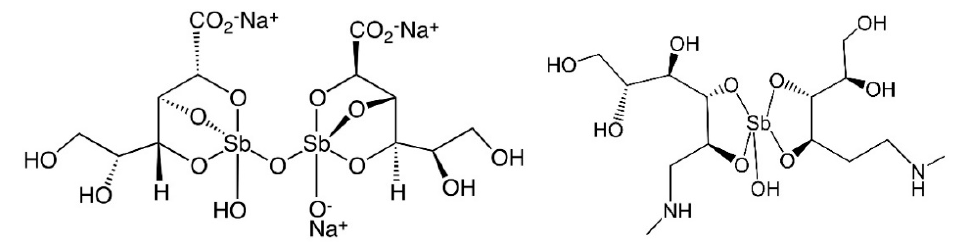
Figure 8. Chemical structures of the clinically-used Sb(V) drugs: sodium stibogluconate ( left ) and meglumine antimoniate ( right ).